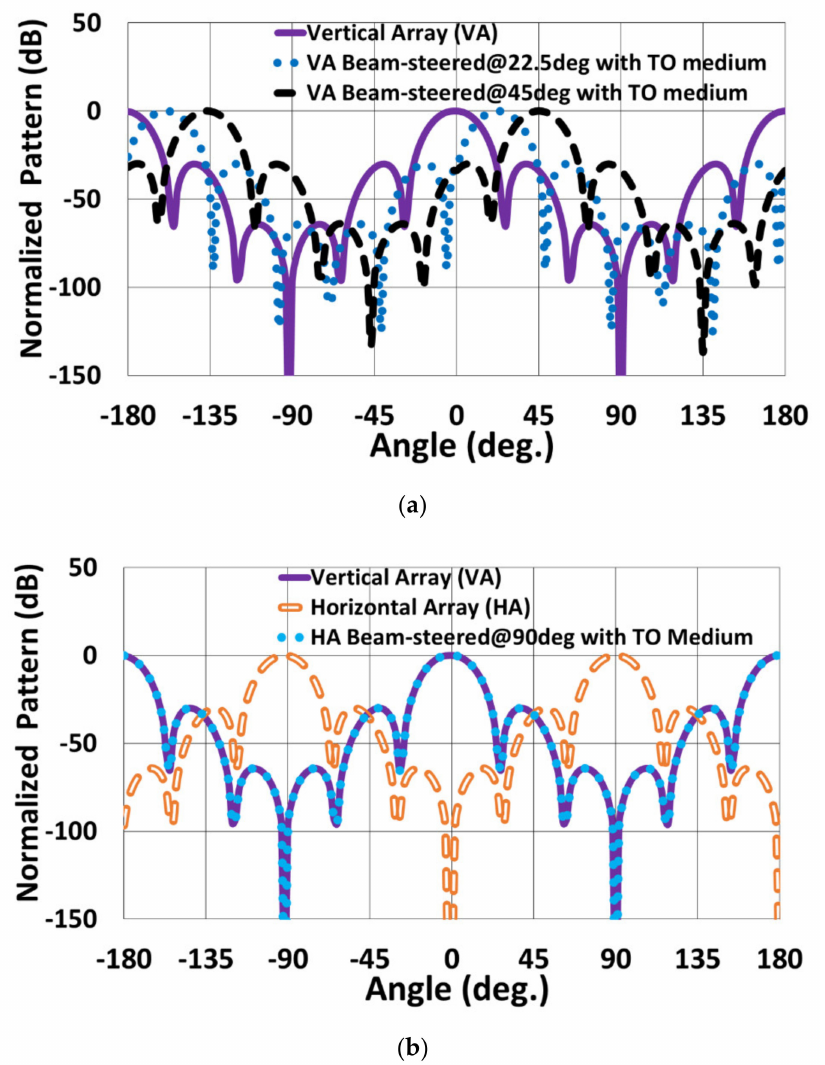
Figure 9. Far-field radiation pattern of proposed antenna array enclosed by TO-based material- embedded cylindrical beam-rotator ( a ) beam-scanning of the “virtual array” at ∅ s = 22.5 ◦ and ∅ ◦ ; ( b ) beam-scanning of the “horizontal array” at ∅ s = 45